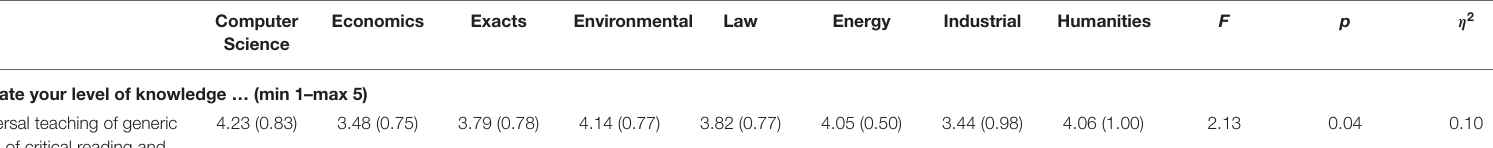
TABLE 2 | Tests of the inter-subject effects of the professors on the instructional variables in ARC considering the department as a grouping variable. Department Computer Economics Exacts Environmental Law Energy Industrial Humanities F p η Science